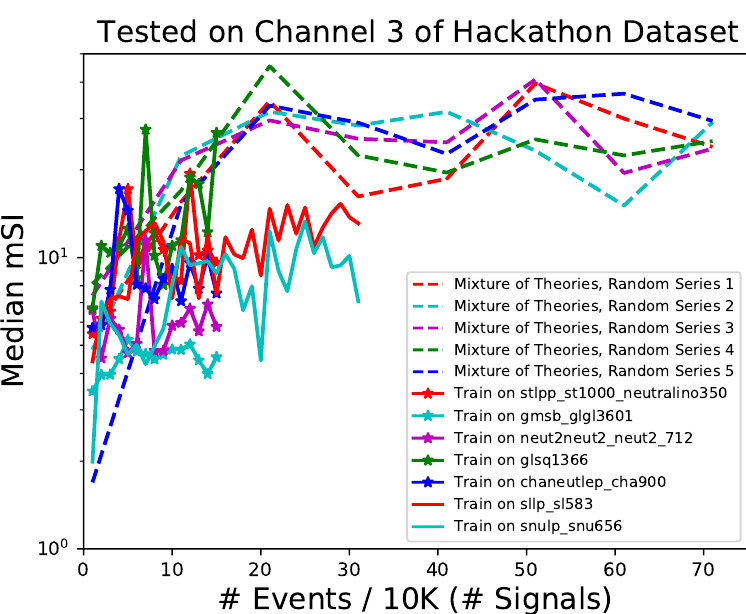
Figure 6 . The figure shows the median values of maximum significance improvements for all test signals from trained models for channels with hadronic final states, tested on signals from hackathon data . For dashed line, the training processes based on increasing number of signals with point size equaling to 10000 are repeated 5 times per channel in random series. The steps of adding signals to training set are (5, 10) for (Channel 1, Channel 3) respectively, while all channels begin from the model with only one signal in the training set. For the star lines, we only use 1 single signal and gradually increase the event number with step equaling to 10000. The solid lines are similar with star lines trained on single signal. However, extra events are generated to extend the